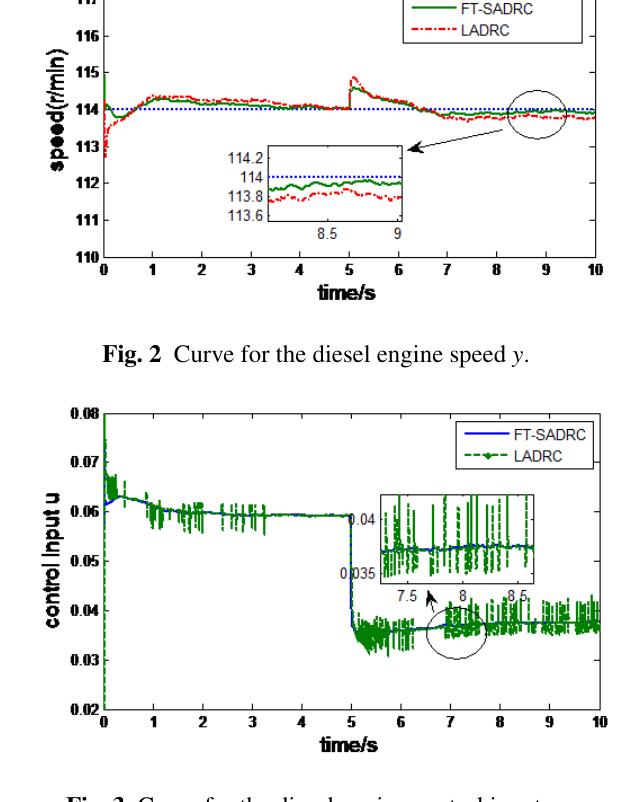
Fig. 3 Curve for the diesel engine control input u